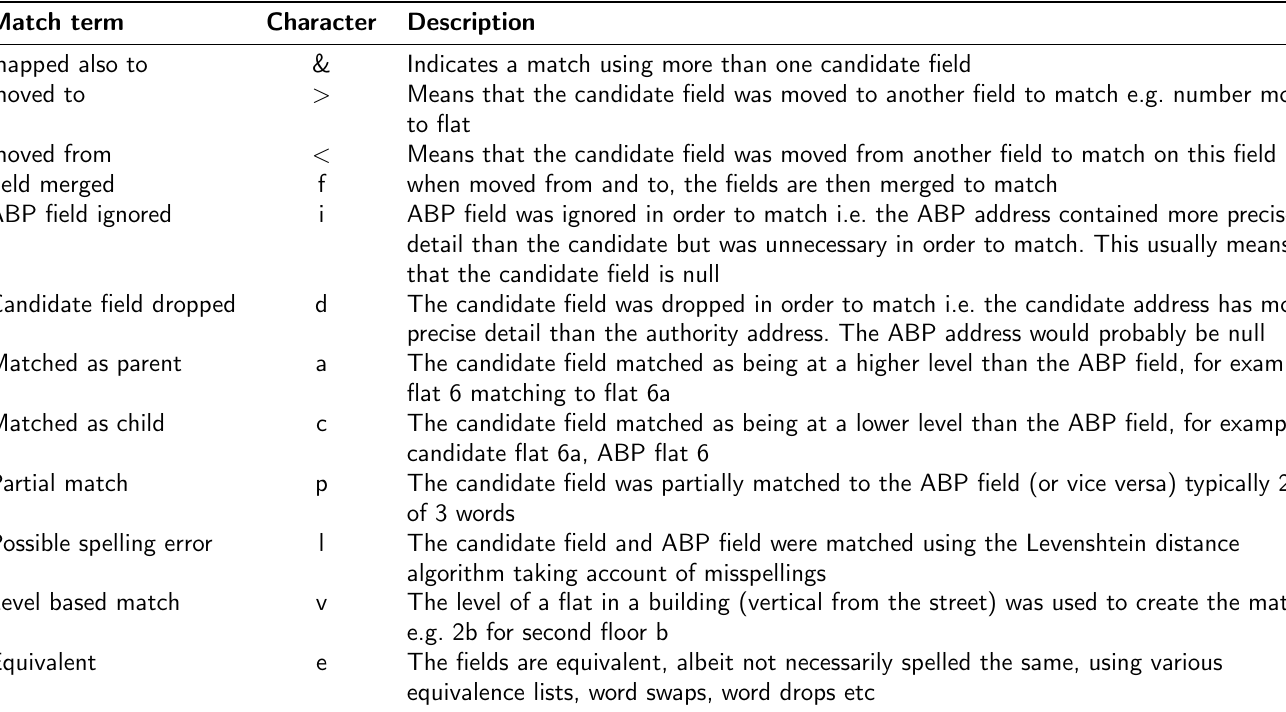
Table 1: The twelve match terms applied to the five address fields to describe the match pattern Match